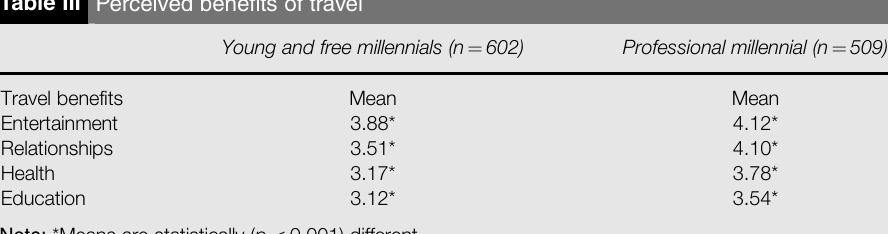
Table III Perceived benefits of